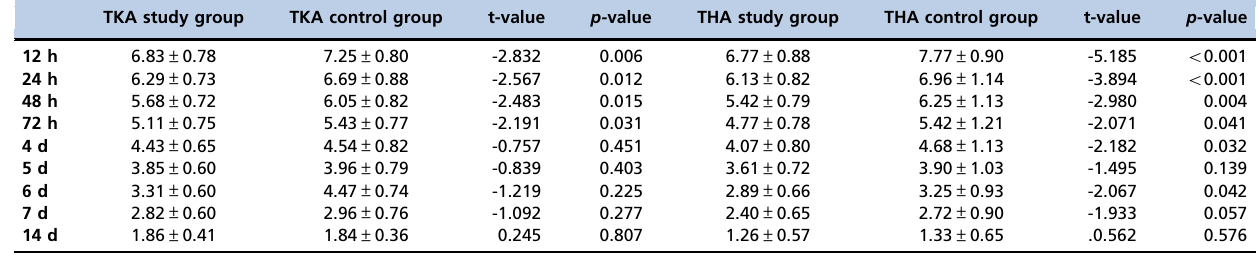
Table 2 - The NRS scores with activity.